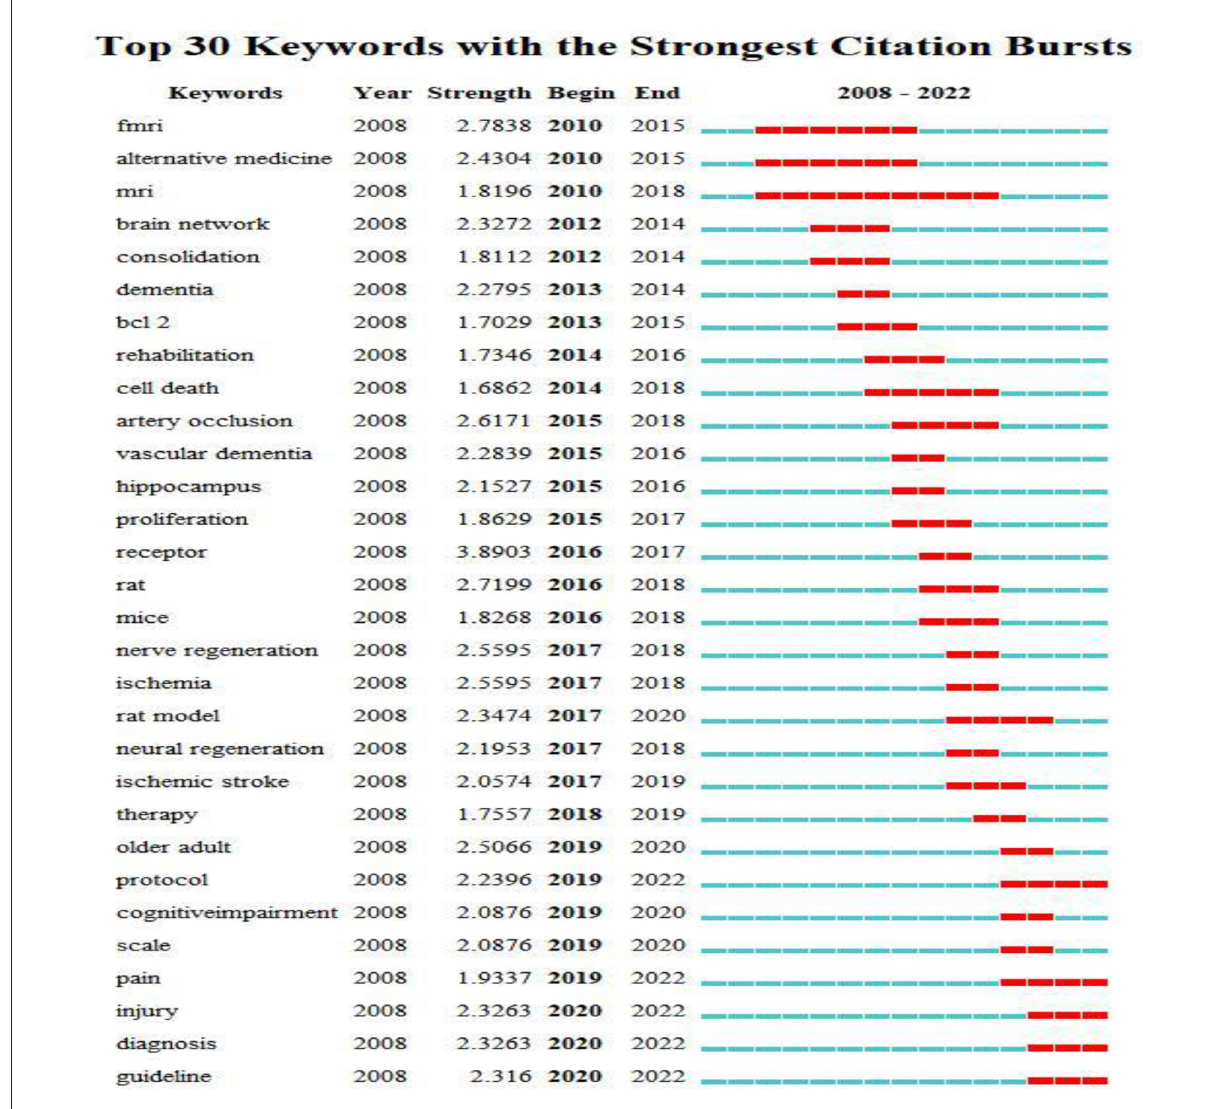
FIGURE10 Top 30 keywords with the strongest citation bursts. The red bars mean the keywords occurred frequently; the green bars mean the keywords occurred infrequently. A greater strength indicates a higher frequency of occurrence.